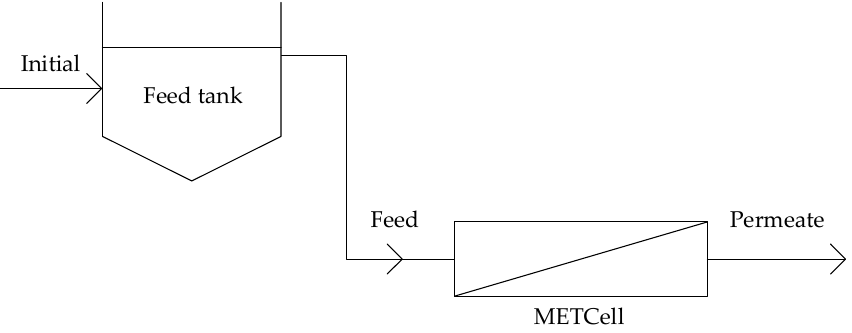
Figure 3. Schematic diagram of adsorption coupled with filtration treatment.